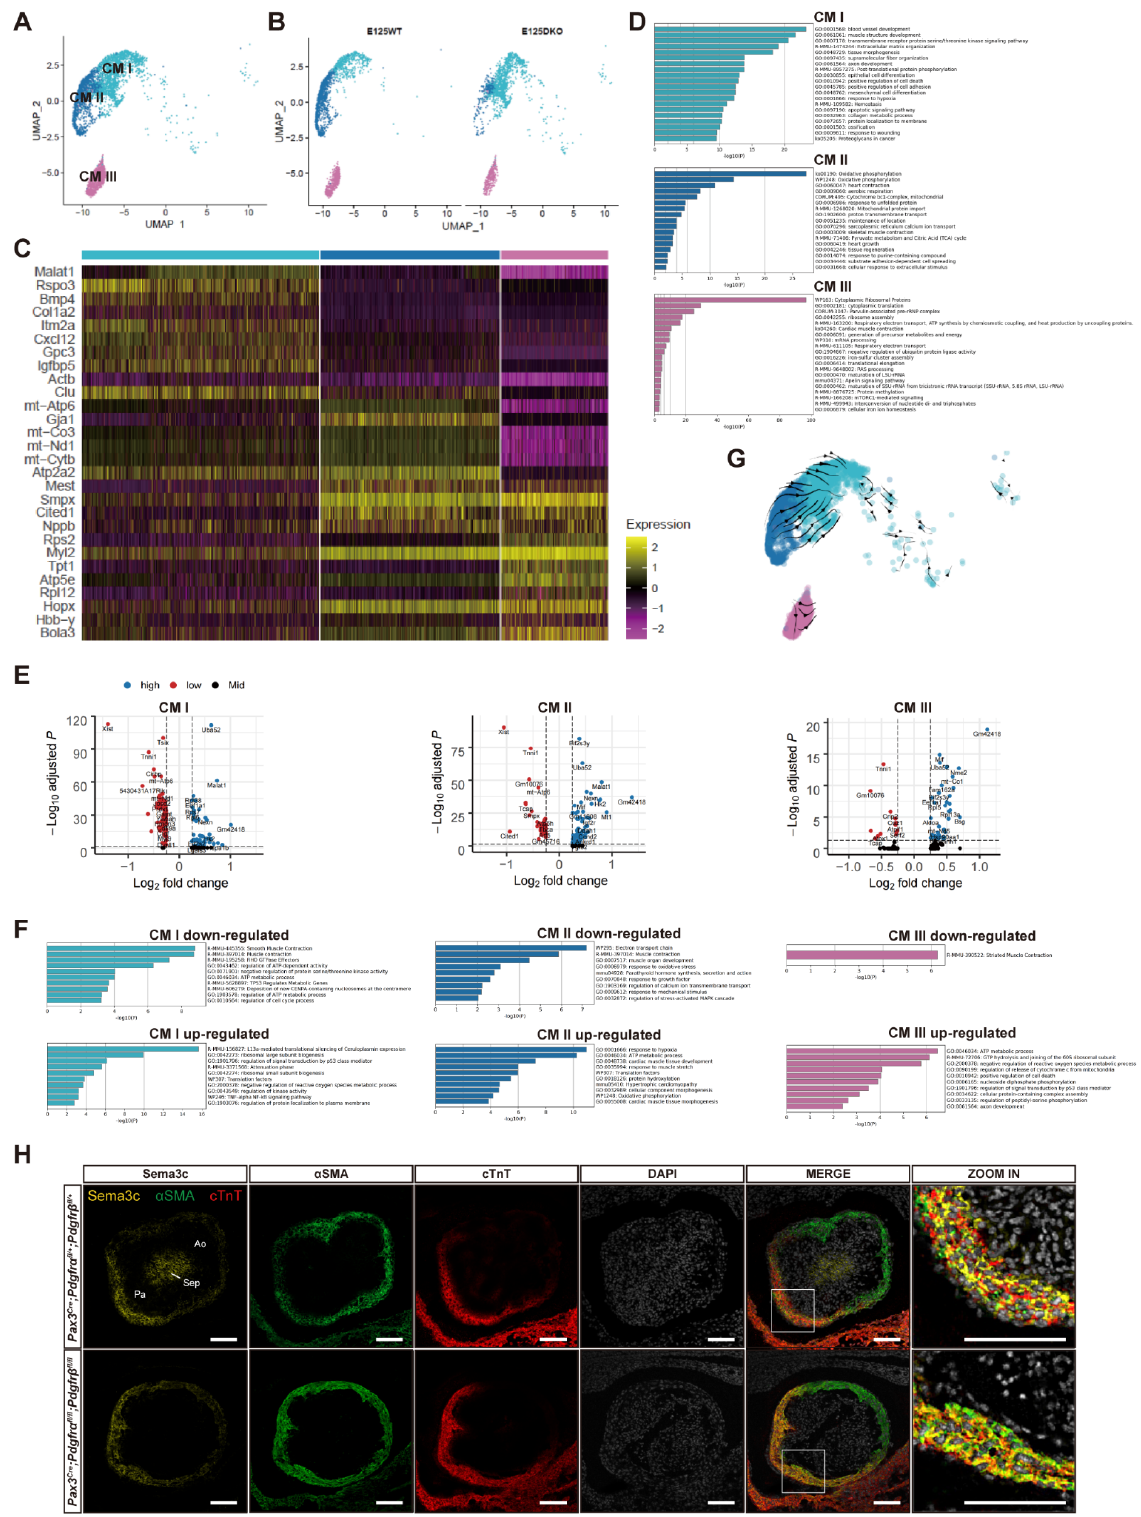
Figure 4. CM clusters and changes after PDGFR α and PDGFR β knockout. ( A ) UMAP plot of all captured CM populations colored by cluster identity (CM I, II, and III). ( B ) Cell cluster distribution of the DKO and control group on UMAP plots revealed that there was a significant difference in the proportion of CM I and II between the DKO and control group. ( C ) Heatmap showing top 10 cluster-specific genes for each CM subcluster. ( D ) Functional enrichment of genes